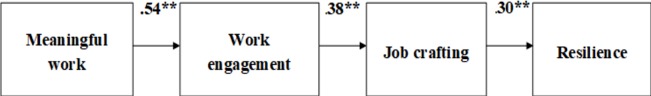
Final results of the proposed model.